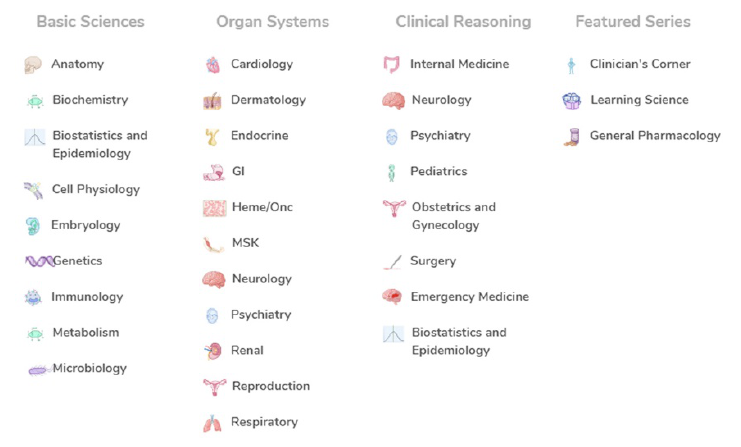
Figure 2 Screen shot of Categories with subjects underneath